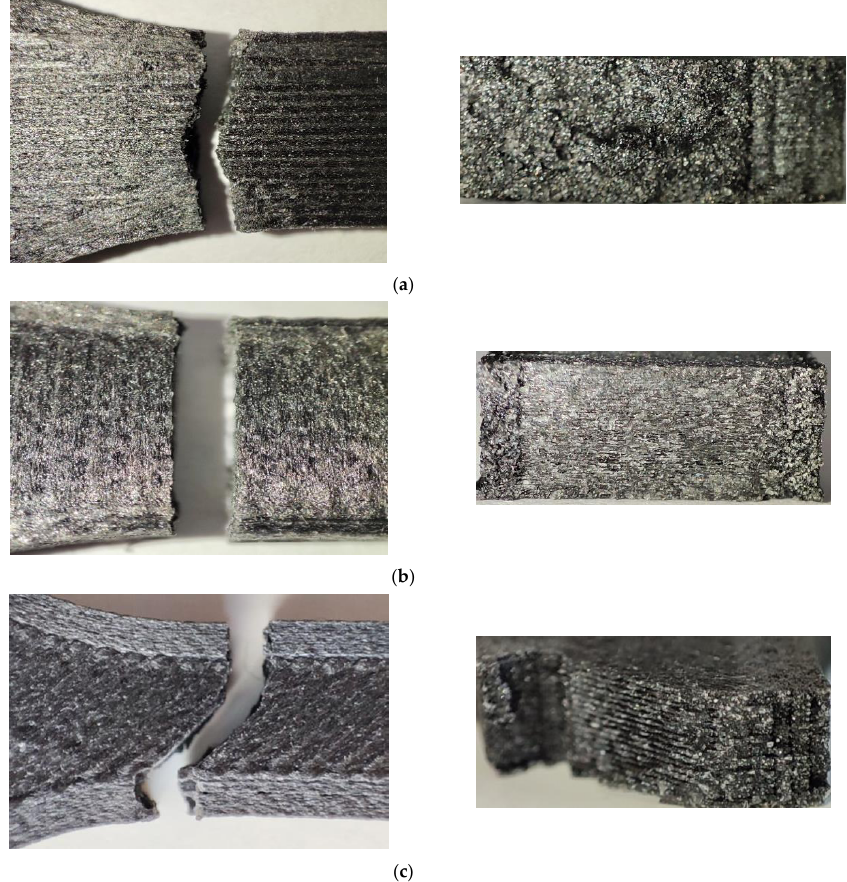
Figure 7. Fracture surface (top view of samples, left, and cross-section of samples, right): ( a ) raster angle of 90 degrees; ( b ) raster angle of 0 degrees; ( c ) raster angle of 45 degrees.